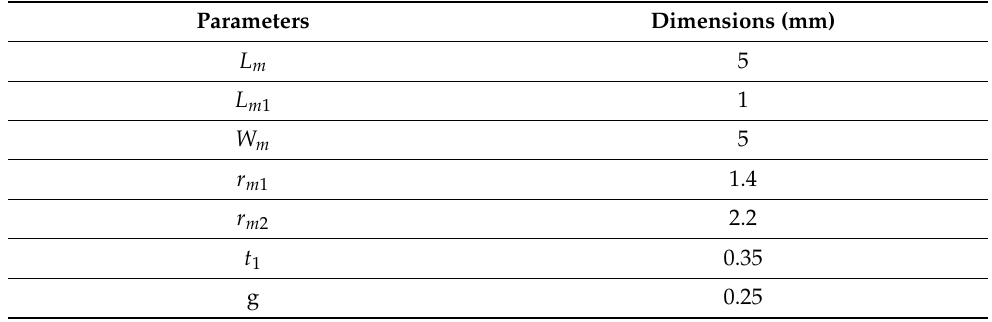
Table 3. MTM structure dimensions.